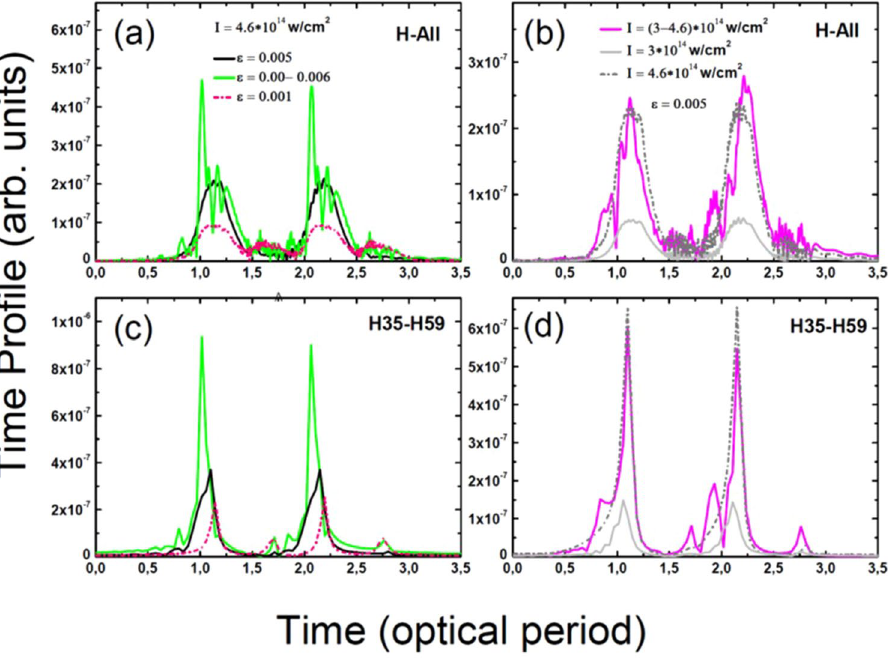
Figure 5. Train of pulses of harmonics emitted by a neon atom calculated from amplitudes and phases shown in Fig. 4. Panels (a and b) give train of pulse from all the harmonics and panels (c and d) show train of pulse from harmonics 35st to 59st. Red and black colors depict the cases when the atom exposed to a constant laser field ( I = 4.10 14 W / cm²) with ε = 0.001, ε = 0.005, respectively. We select here only the short trajectory. Green color present the case when intensity of the field is constant ( I = 4.10 14 W / cm²) and an inhomogeneity varying from ε = 0 to ε = 0 . 006 with steps of 0.001. Dashed gray and solid gray colors show the case with constant inhomogeneity factor ε = 0 . 005 and intensities ( I = 3.10 14 W / cm²) and (I = 4.6.10 14 W / cm²), respectively. Magenta color depict the train of pulses of harmonics calculated as the coherent sum of all spectra computed at constant inhomogeneity factor ( ε = 0 . 005 ) with field intensity from ( I = 3.10 14 W / cm²) to (I = 4.6.10 14 W / cm²) with steps of (I = 0.1.10 14 W /